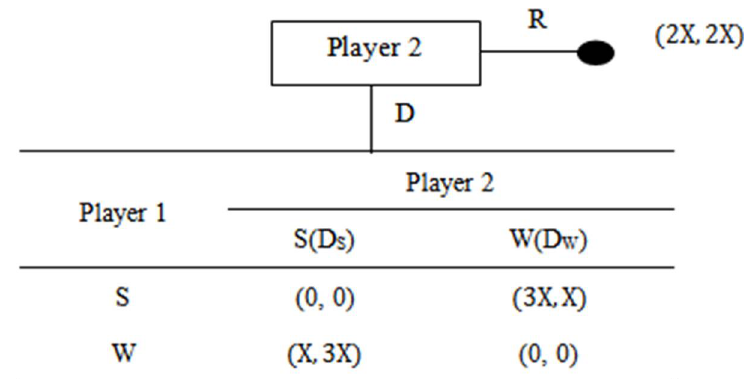
Figure 1. Two-stage van Damme’s game matrix with two players.